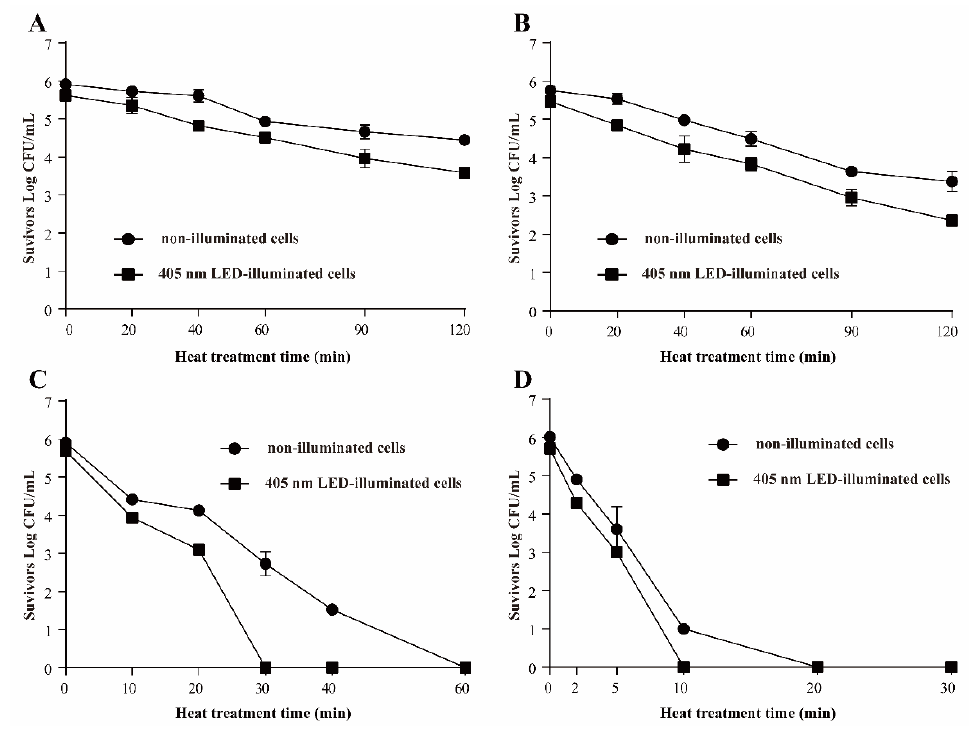
Figure 3. Survival curves at 50 °C ( A ), 55 °C ( B ), 60 °C ( C ), and 65 °C ( D ) for S . Typhimurium. ( ● ) ( • ) non-illuminated cells, ( (cid:4) ) 405 nm LED-illuminated non-illuminated cells, ( ■ ) 405 nm LED-illuminated cells.